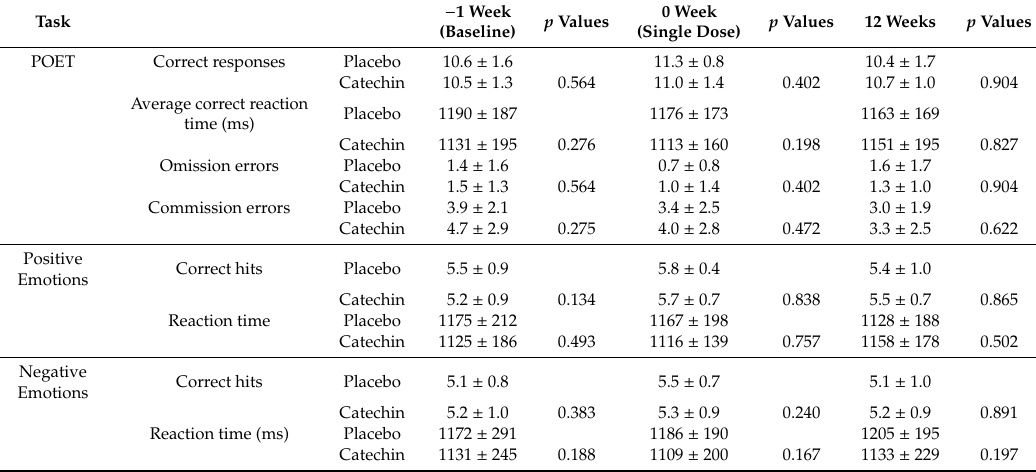
Table 4. E ff ects of green tea catechins on facial expression recognition-related